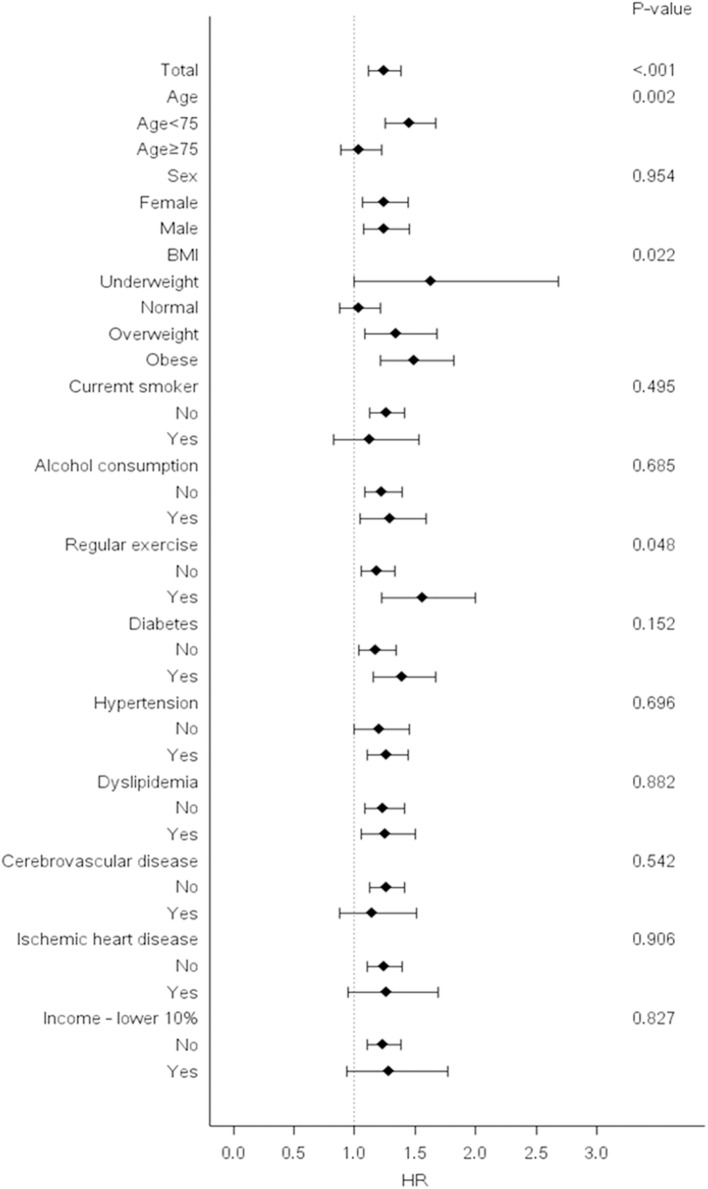
Risk of dementia in the highest vs. lower three quartiles of body weight (Bwt) variability in subgroups. Hazard ratios and 95% confidence intervals for the risk of dementia in the highest quartile (Q4) vs. lower three quartiles (Q1–Q3) of Bwt variability in subgroups. BMI, body mass index; HR, hazard ratios.